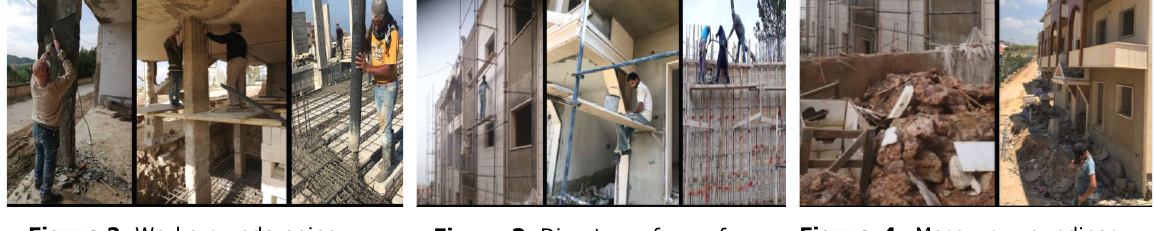
Figure 3. Disastrous form of scaffolding and absence of PPE